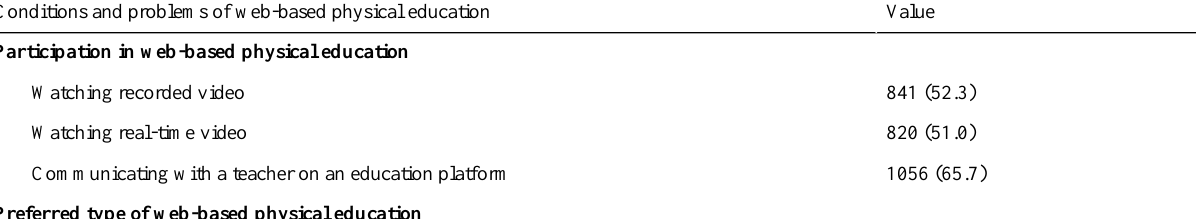
Table 5. The conditions and problems of web-based physical education (N=1607), n